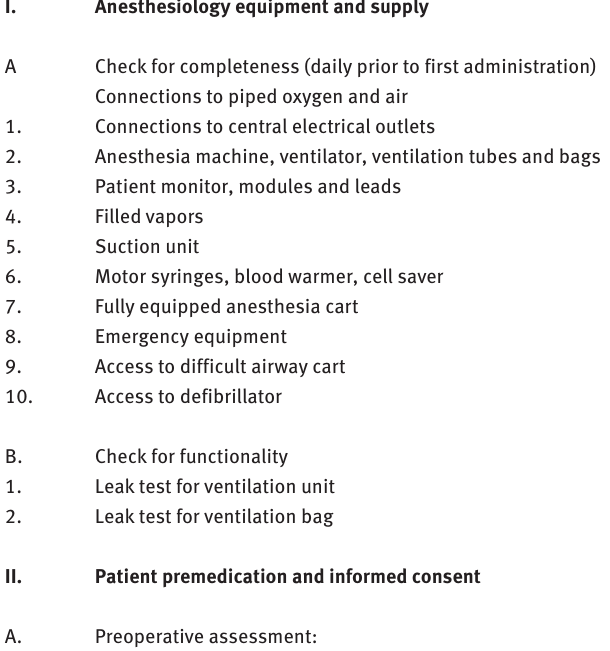
Table 1: Pre-operative SOP before